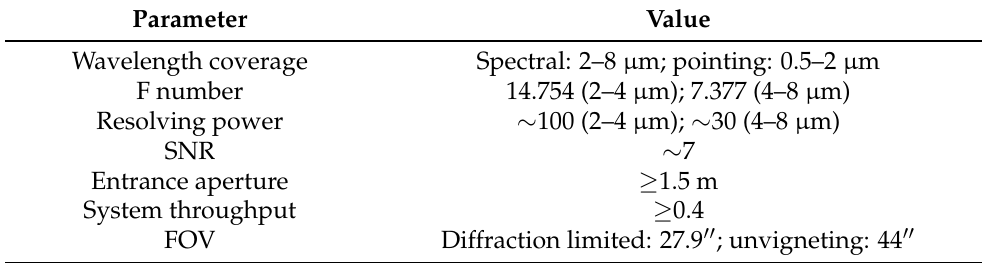
Table 5. Summary of optical